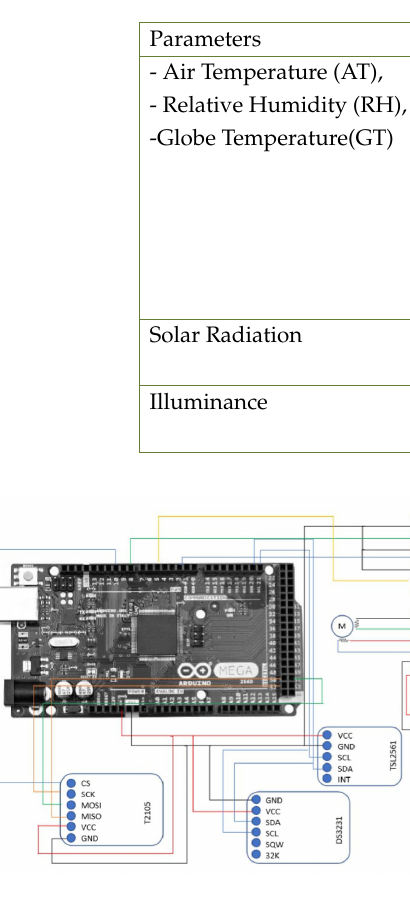
Fig. 2. Configuration of sensors and acquisition data system.